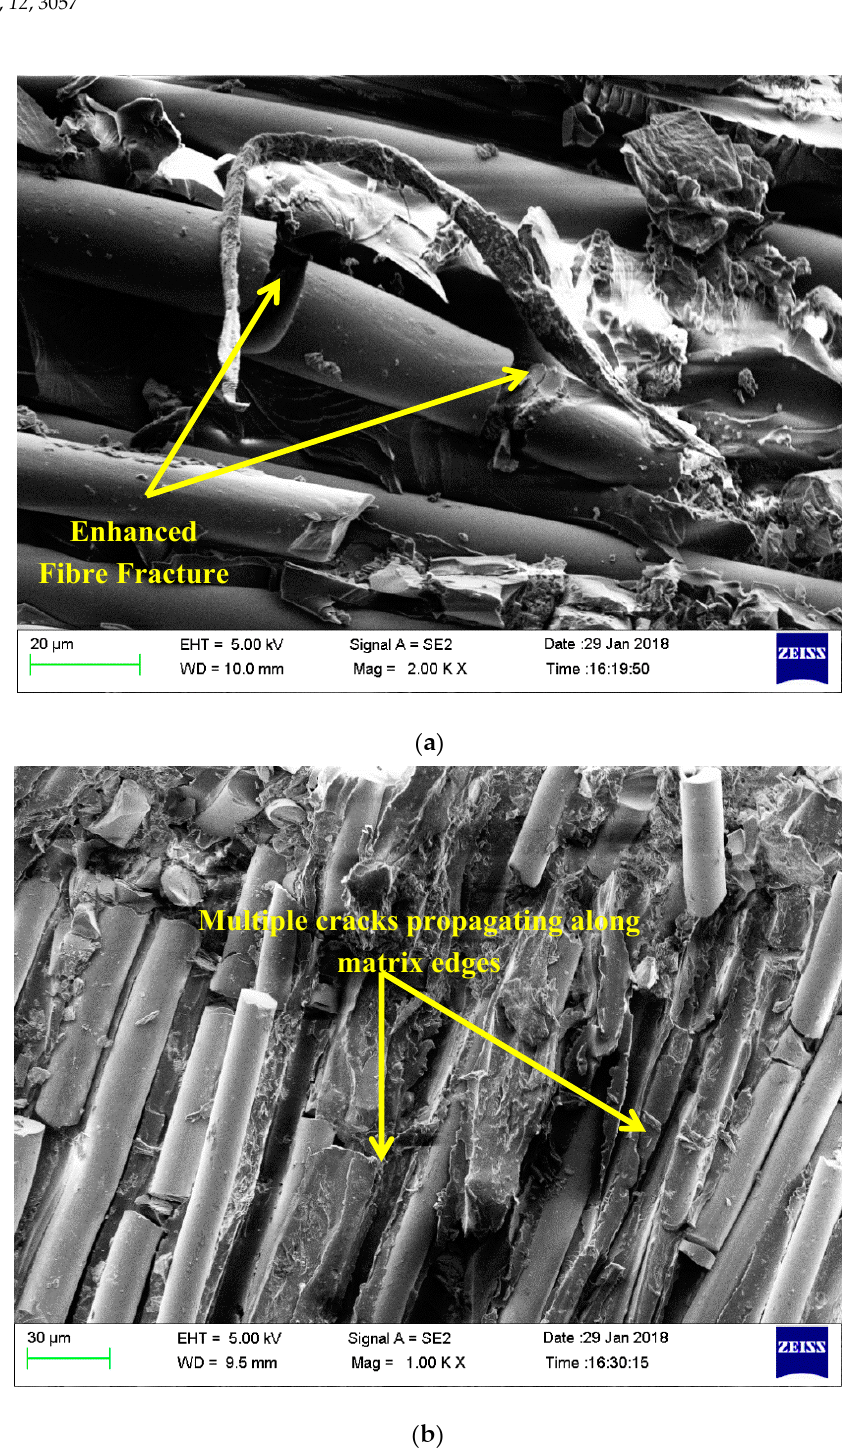
Figure Figure 8. Fracture analysis of toughened composites with 0.75 wt% nanosilica as secondary reinforcements ( a ) Enhanced fibre damage; ( b ) Crack initiation and propagation in matrix.